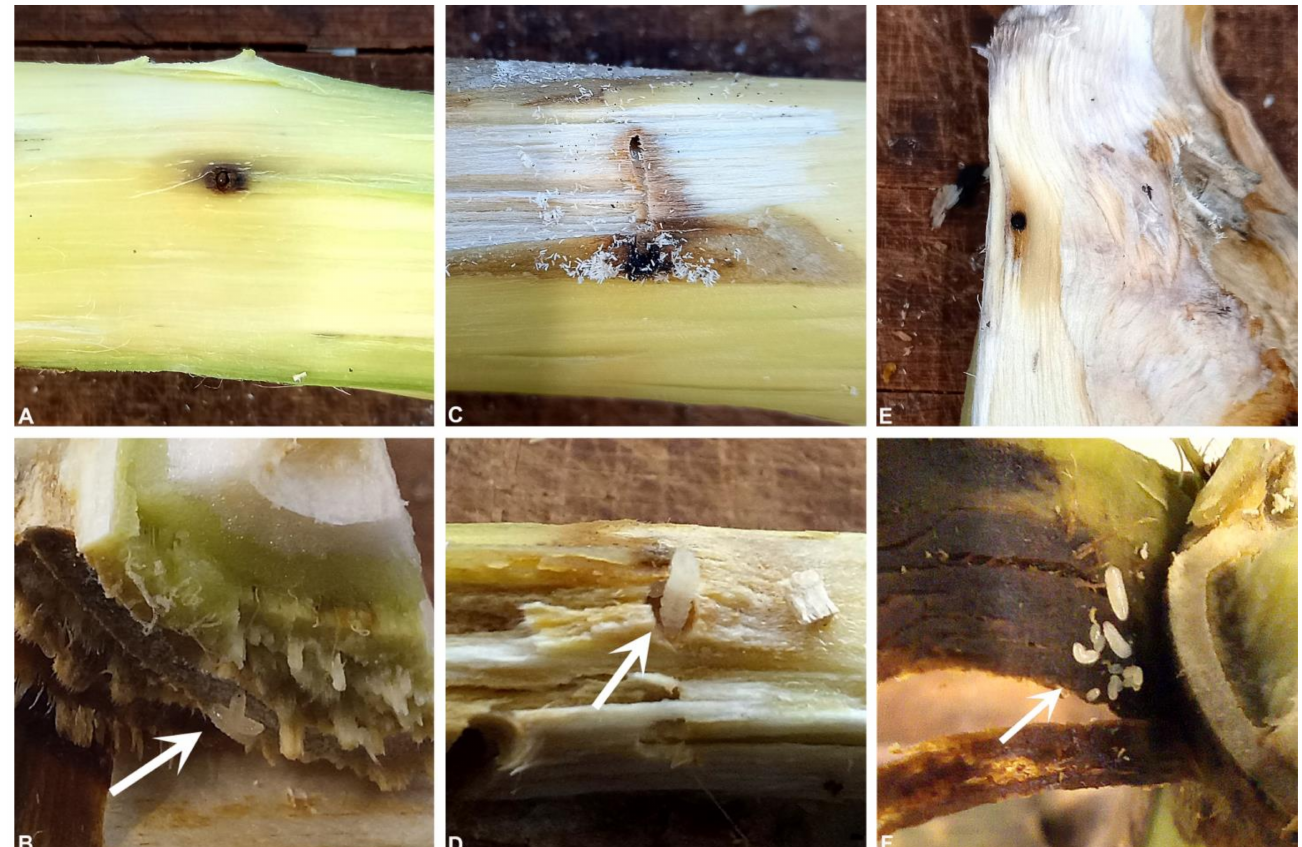
Figure 4. Beetles were able to infest ( A , C , E ) and reproduce ( B , D , F ) in castor bean stems treated with various doses of the entomopathogenic agents. Larvae (arrows) were found present in replicates of all treatments, excluding those of the recommended dose application of Bio-Insek. Shown here are replicates of control ( A , B ), 10 × Eco-Bb ® ( C , D ) and 10 × Bio-Insek ( E , F )